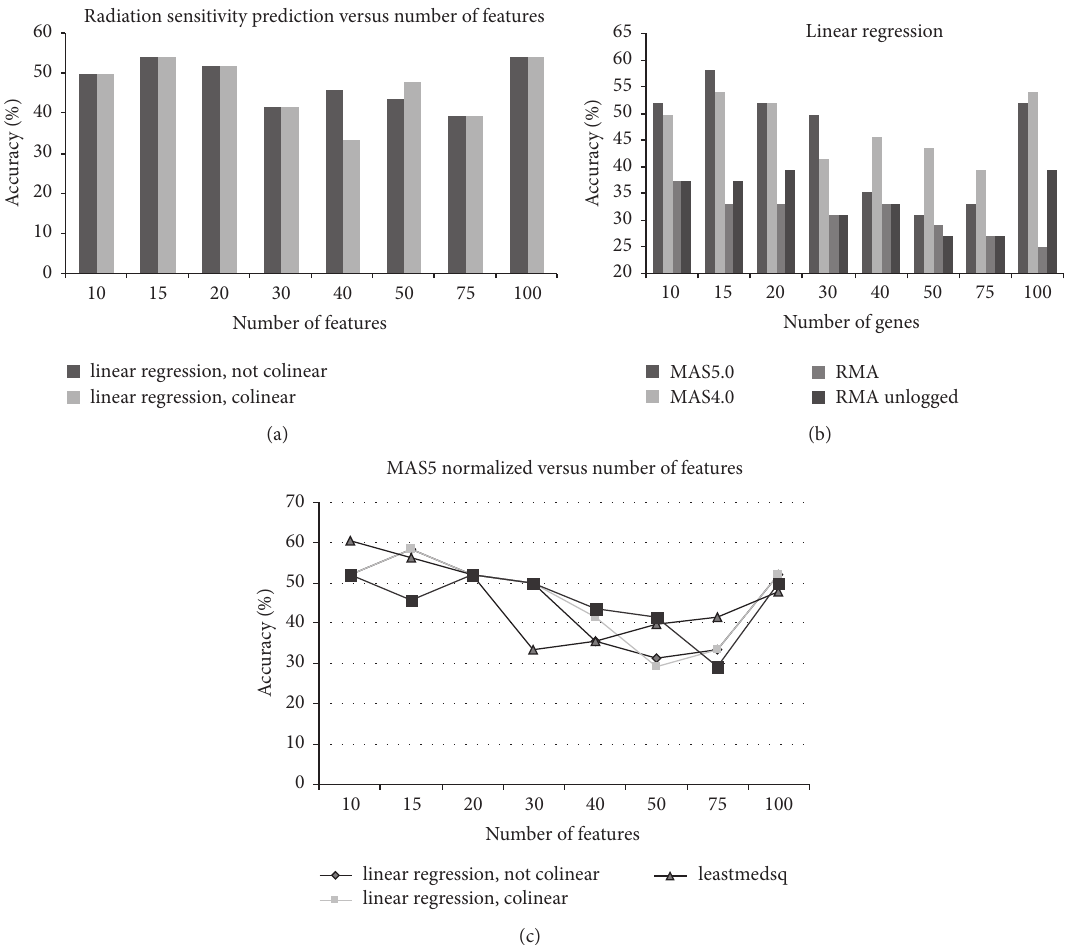
Figure 1: Investigation of building predictors for radiation sensitivity in 48 cell lines. (a) Classification accuracy of radiation sensitivity predictor built from 48 cell lines, using different numbers of features in the regression model. (b) Classification accuracy of radiation sensitivity predictor built from 48 cell lines, using different types of normalization. MAS5.0 and MAS4.0 algorithms generated the most accurate predictors. (c) Classification accuracy of radiation sensitivity predictor built from 48 cell lines, using different types of classification algorithms, including linear regression, least median, and SMO.